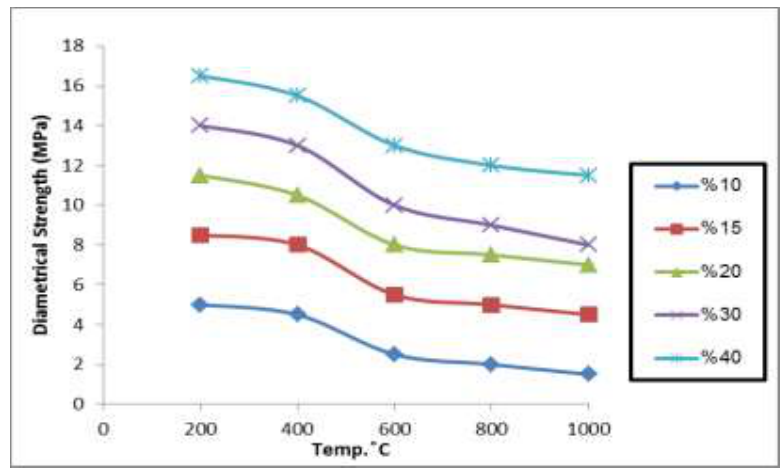
Figure 6: Diametrical Strength for kaolin